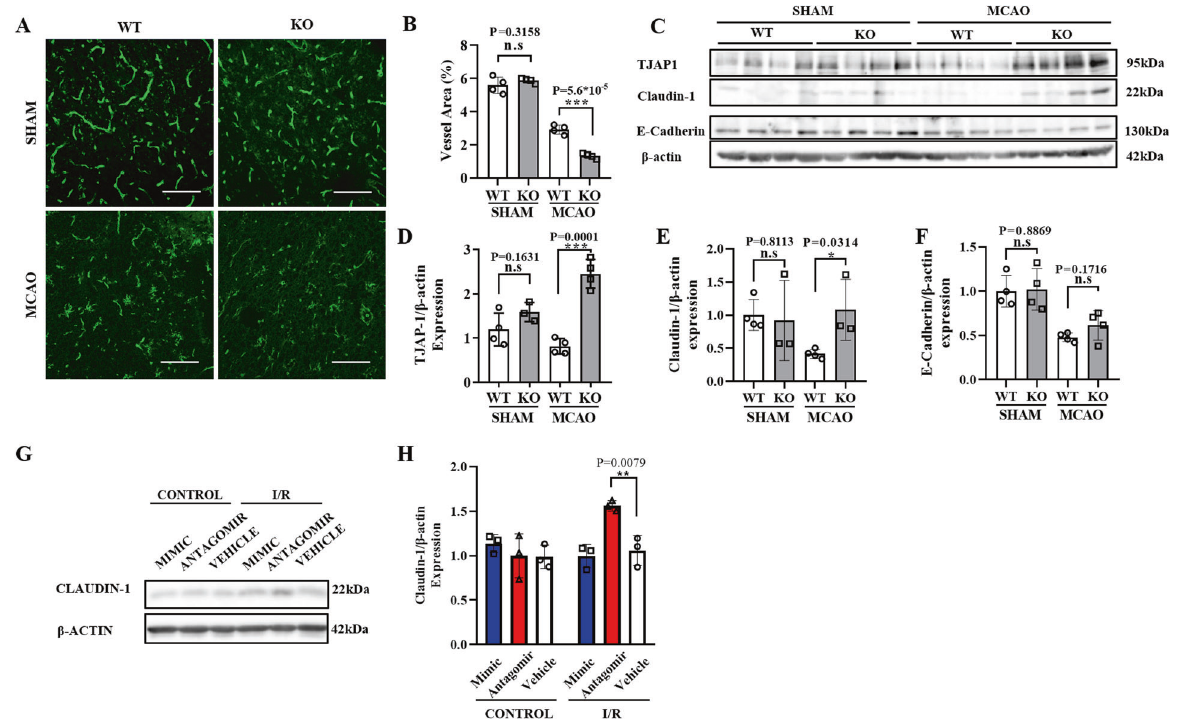
Fig. 5 CRTC1 de fi ciency suppresses vascular bed and destabilizes tight junction proteins in ischemic mice brains. Representative images ( A ) and quanti fi cation ( B) of Lycopersicon esculentum Lectin immuno fl uorescence staining of mice penumbra (Scale Bar, 100 μ m). Representative western blot images ( C ) and quanti fi cation of TJAP-1 ( D ), Claudin-1 ( E ), and E-Cadherin ( F ) expression after MCAO. Representative Western Blot images ( G ) and quanti fi cation ( H ) of Claudin-1 in mouse brain microvascular endothelial cells (BMECs) transfected with miR-132 mimic/antagomir/vehicle, before and after